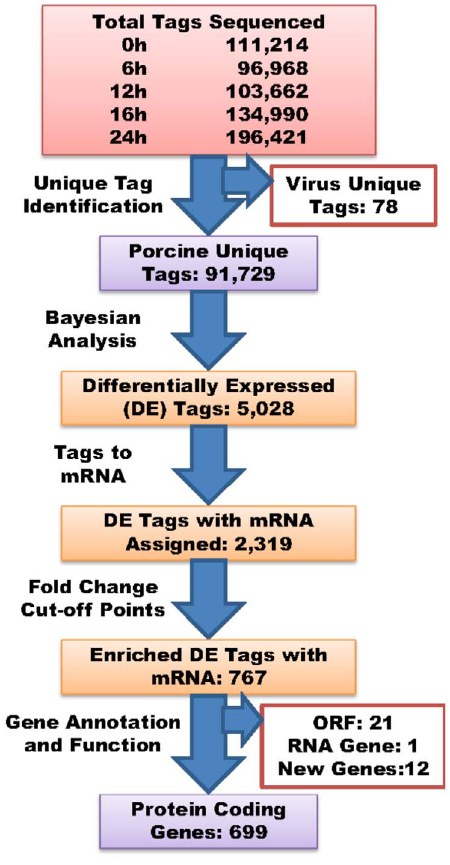
Figure 1. Identification and characterization of tags/genes differentially expressed between the 0 hour mock-infected and the 6, 12, 16 and 24 hours PRRSV-infected PAM cells.